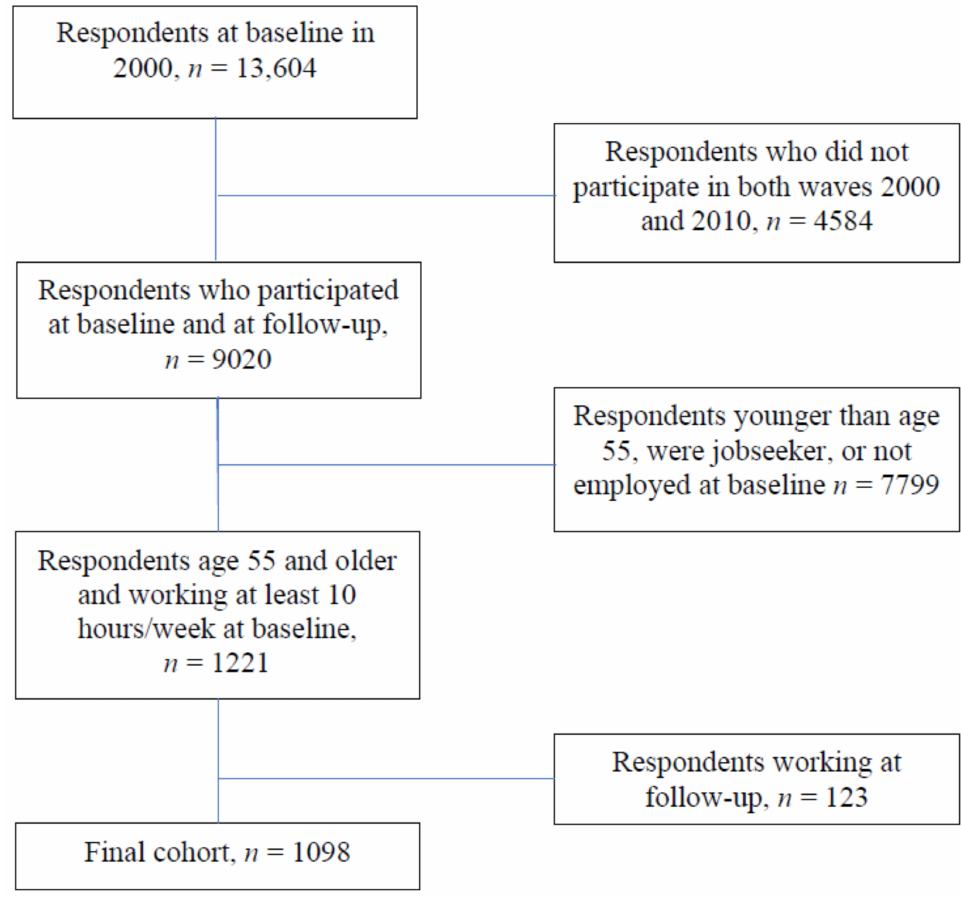
Figure 1. Flow chart of the study